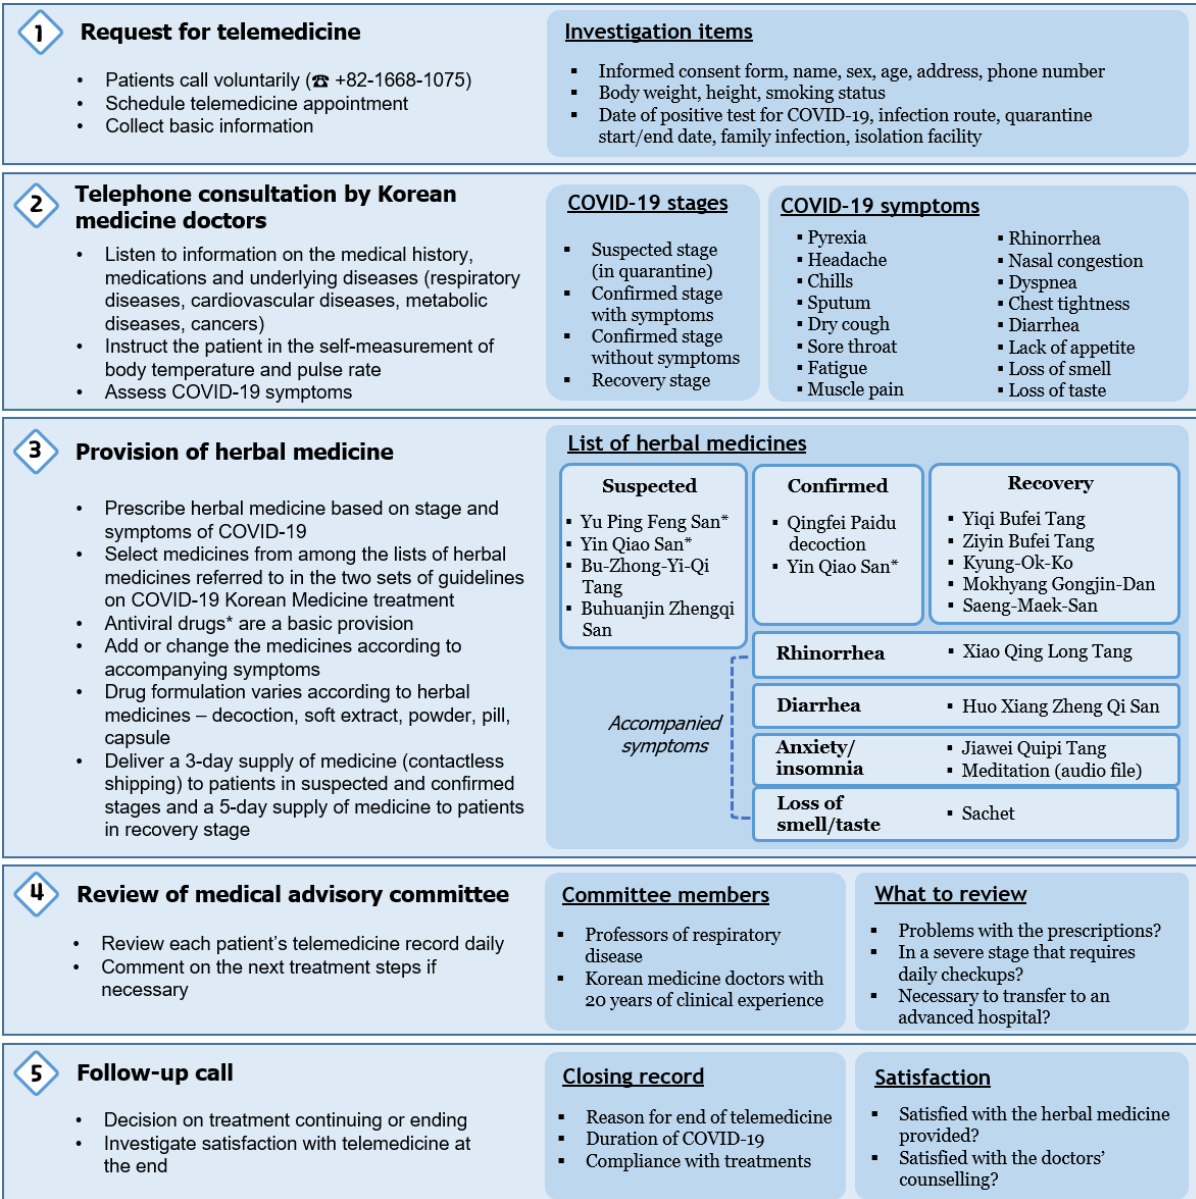
Figure 3. Flow diagram of steps undertaken by the COVID-19 telemedicine center of Korean Medicine.